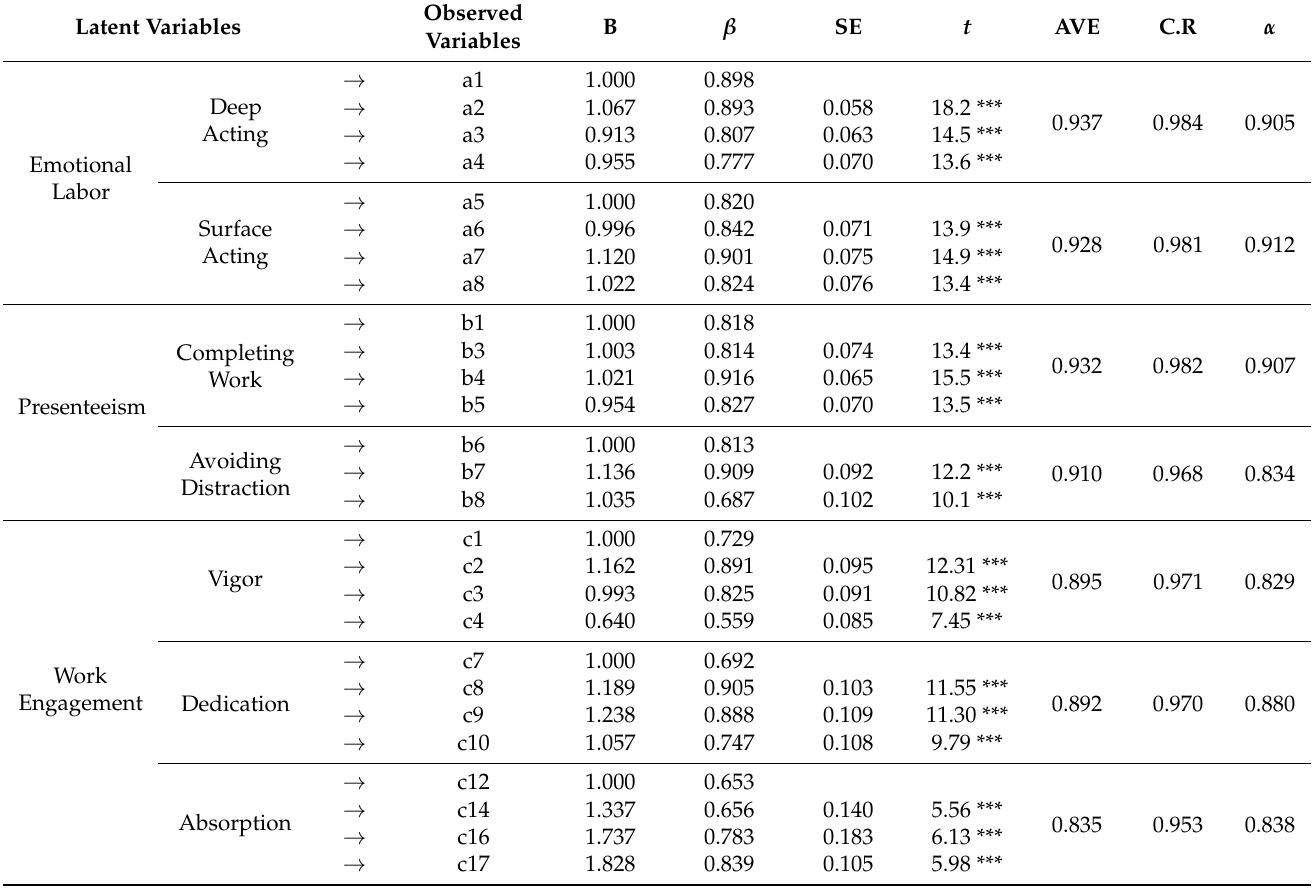
Table 2. Reliability and Validity of